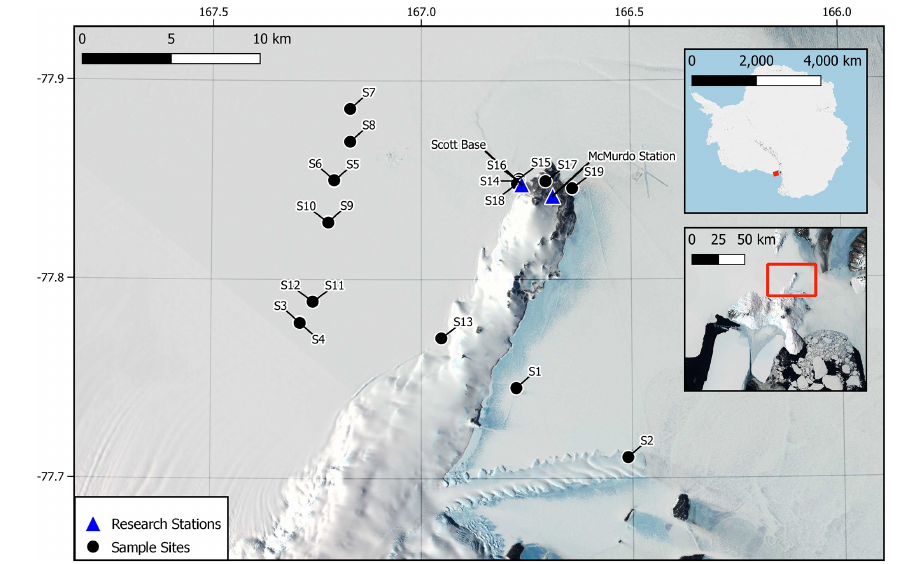
Figure 1. Site locations for snow sample collections across the Ross Island region of Antarctica (S1–S19). Sample sites are marked in black, and locations of scientific research stations are shown by blue triangles. Some site markers correspond to two sampling sites due to the scale of the map. Map data sourced from Matsuoka et al.